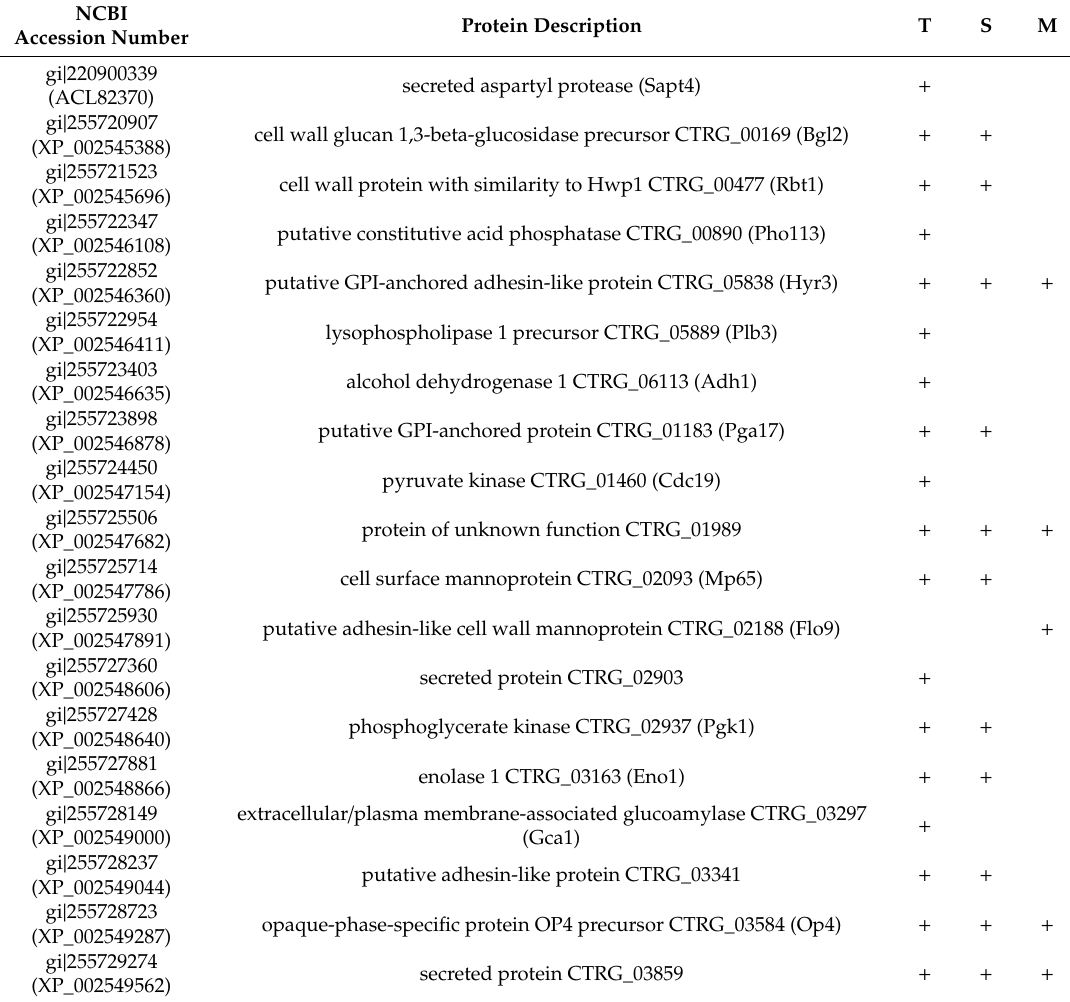
Table 5. Mass spectrometry identification of abundant proteins in C. tropicalis EVs after vesicle surface shaving with trypsin (T) or vesicle sonication (S), and in EV membrane protein-enriched fractions (M). The resulting peptides were analyzed using the Dionex Ultimate 3000 UHPLC system coupled to an HCTUltra ETDII mass spectrometer and the obtained lists of peaks were searched against the NCBI protein database using an in-house Mascot